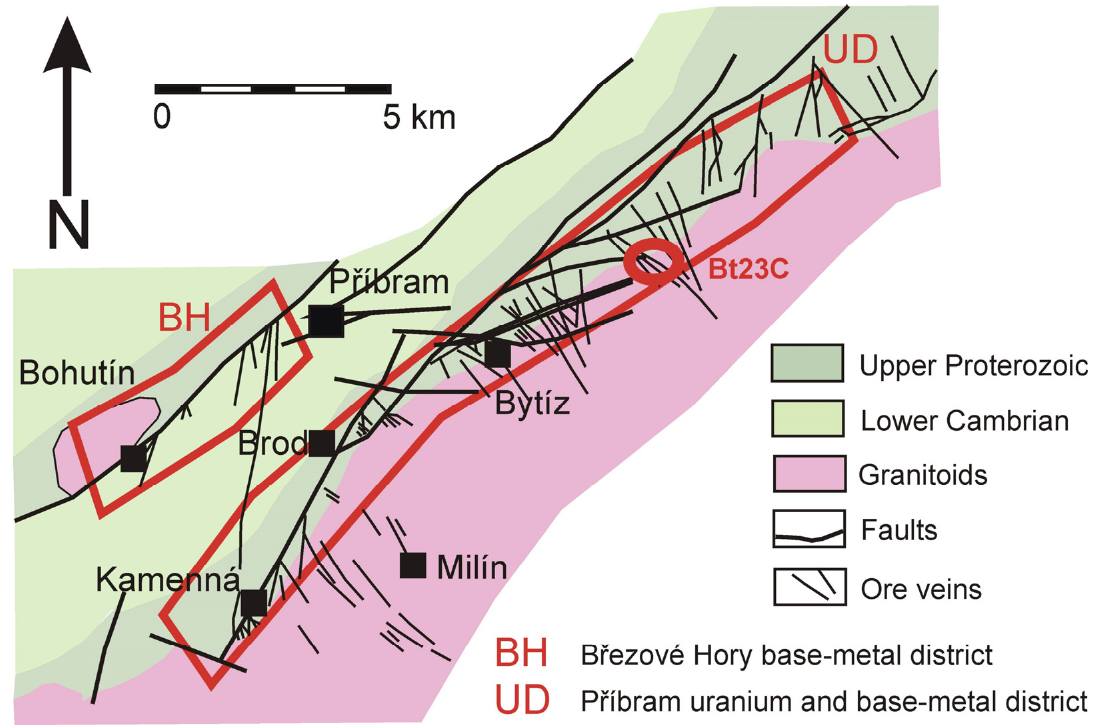
Figure 1. Geological position of the P ř íbram ore area and studied vein Bt23C, modified from Ettler et al. [1].